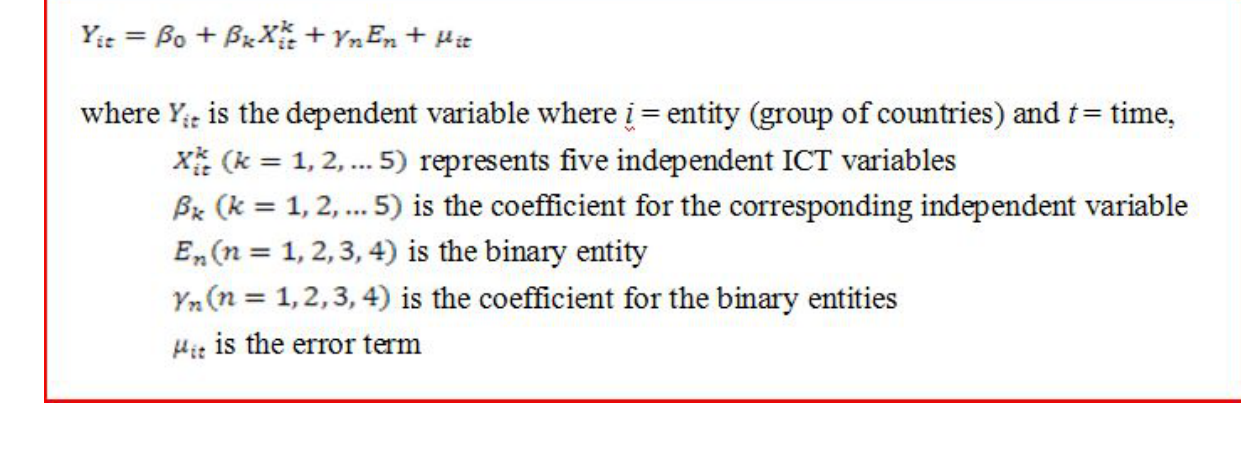
Figure 2. Fixed effect